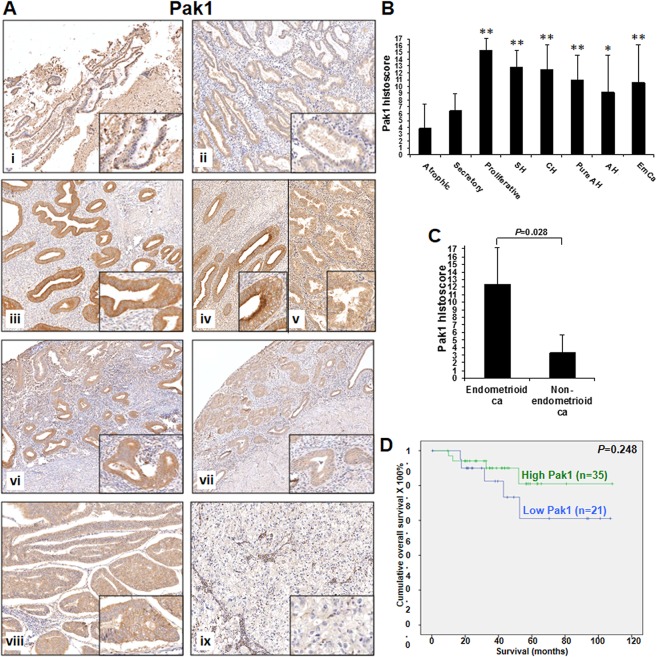
(A) Pak1 immunoreactivity in normal atrophic endometrium (i), secretory endometrium (ii), proliferative endometrium (iii), simple hyperplasia (iv), complex hyperplasia (v), pure atypical hyperplasia (vi), atypical hyperplasia (vii), endometrioid carcinomas (viii) and non-endometrioid carcinomas (ix). (B) Bar chart showing the immunoreactivity of Pak1 in normal atrophic endometrium (Atrophic), secretory endometrium (Secretory), proliferative endometrium (Proliferative), simple hyperplasia (SH), complex hyperplasia (CH), pure atypical hyperplasia (Pure AH), atypical hyperplasia (AH) and endometrial cancers (EmCa). *, P<0.05; **, P<0.005; compared to normal atrophic endometrium by Mann-Whitney test. (C) Bar chart showing the immunoreactivity of Pak1 in endometrioid carcinomas (ca) and non-endometrioid carcinomas. The immunoreactivity of Pak1 was analyzed by Mann-Whitney test. (D) Kaplan-Meier survival curves for endometrial cancer patients with two different expression levels of Pak1 (cut off at mean).